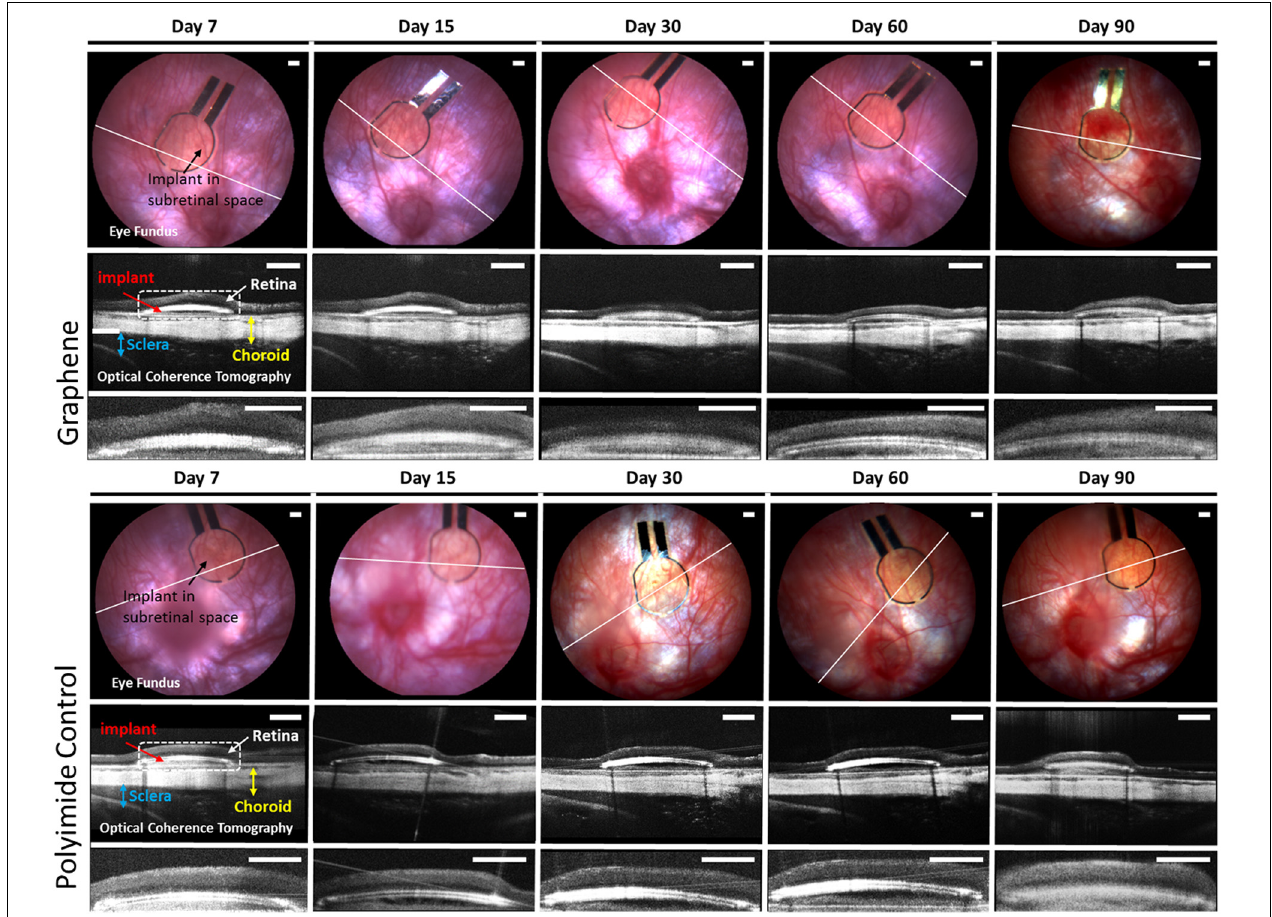
FIGURE 3 | In vivo imaging of devices with graphene (top set) and devices without graphene (bottom set) at different specified time intervals. Each set includes eye fundus (top row) , OCT scans of device in the eye (middle row) , and a magnified image of OCT scan showing only the retina and device (bottom row) . Eye fundus provides evidence for the long-term stability of both types of devices up to 90 days. The white line indicates the location where the OCT scans were taken. The OCT scans shows the implant (red arrow) sandwiched between the retina (white arrow) and the choroid (yellow). Dotted white box is a zoom of each OCT scan showing in detail the retina and device. The magnified images of the OCT scans (bottom row) show the close contact of the retina and implant devices. Bottom row of each set is the zoom on the retina in contact with implant as indicated by dashed line of the OCT scan. All scale bars are 200 µ